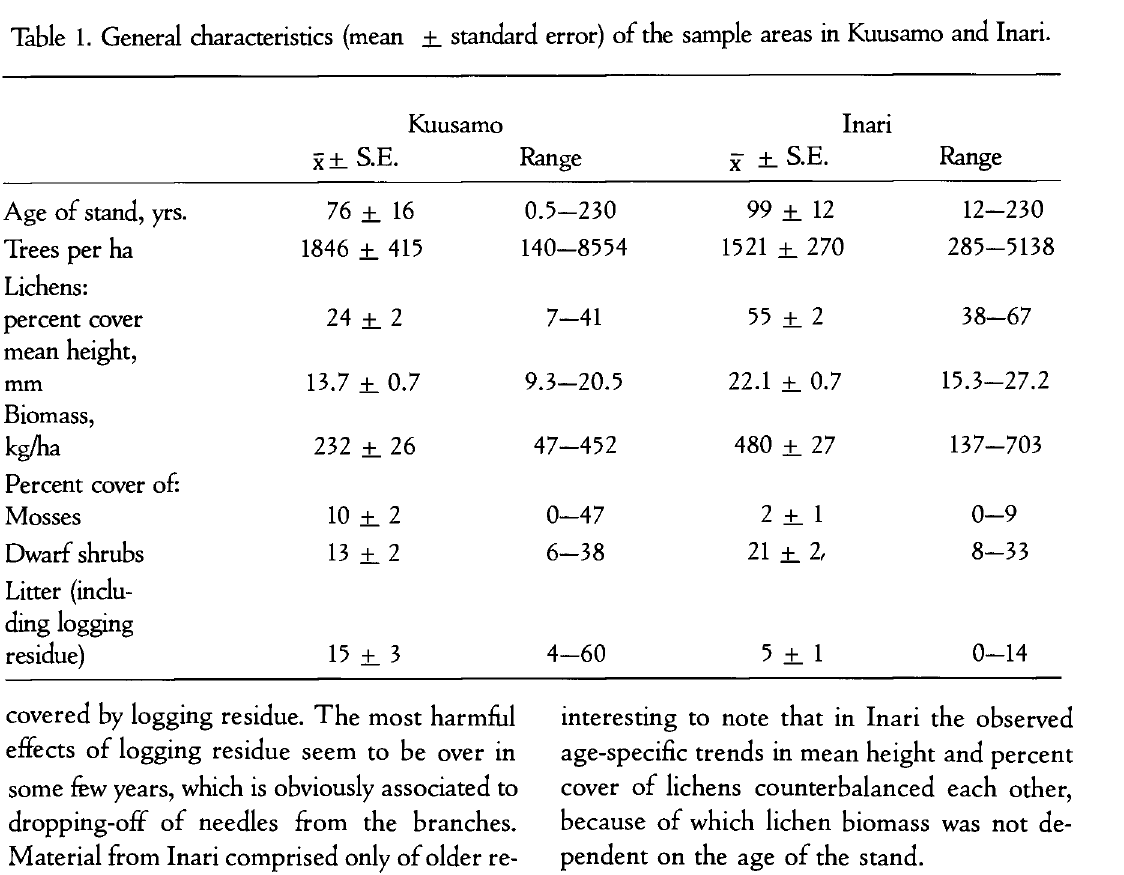
Table 1. General characteristics (mean +_ standard error) of the sample areas in Kuusamo and Inari.